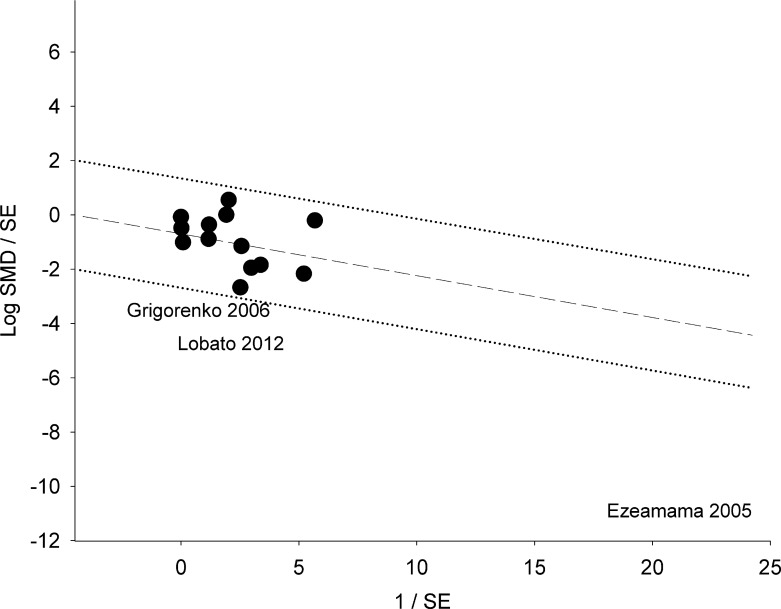
Galbraith plot analysis to identify outliers among included studies of STH infection and performance in learning tests.Log SMD: logarithm of standardized mean difference; SE: Standard error. Studies that lie below the– 2 or above the +2 confidence limit are the outliers.